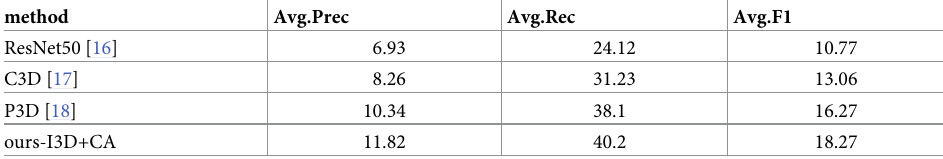
Table 3. Compositional action recognition on LEMMA.